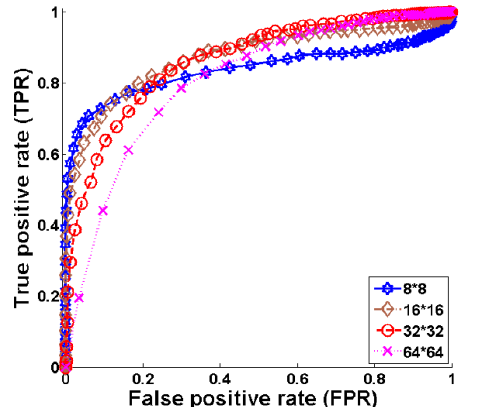
Figure 7. ROC curve comparisons between different block